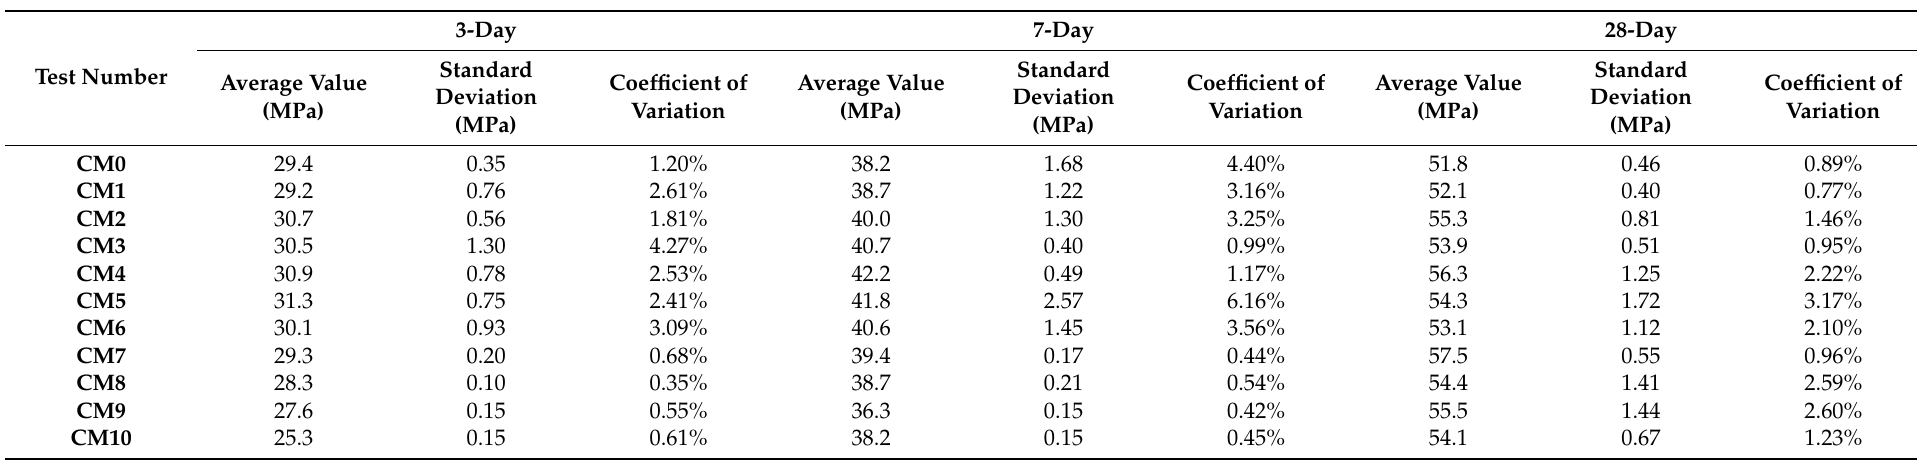
Table 8. Test results of mortar compressive strength of machine-made